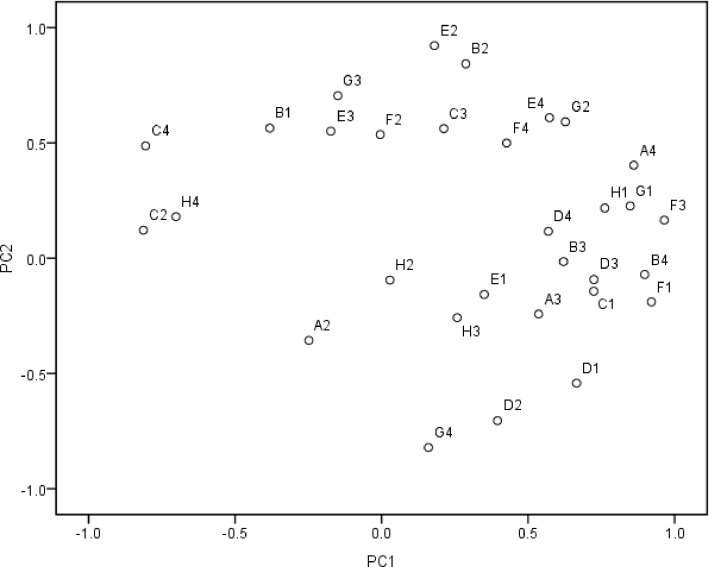
Loadings of 31 carbon substrates on PC1 and PC2 in the principal components analysis of the CLPP results.Carbon source: A1: Water, A2: β-methyl-D-glucoside, A3: D-galactonic acid γ-lactone, A4: L-arginine, B1: Pyruvic acid methyl ester, B2: D-xylose, B3: D-galacturonic acid, B4: L-asparagine, C1: Tween 40, C2: I-erythritol, C3: 2-hydroxybenzoic acid, C4: L-phenylalanine, D1: Tween 80, D2: D-mannitol, D3: 4-hydroxybenzoic acid, D4: L-serine, E1: α-cyclodextrin, E2: N-acetyl-D-glucosamine, E3: γ-hydroxybutyric acid, E4: L-threonine, F1: Glycogen, F2: D-glucosaminic acid, F3: Itaconic acid, F4: Glycyl-L-glutamic acid, G1: D-cellobiose, G2: Glucose-1-phosphate, G3: α-ketobutyric acid, G4: Phenylethylamine, H1:α-D-lactose, H2: D,L-α-glycerol phosphate, H3: D-malic acid, H4:Putrescine.